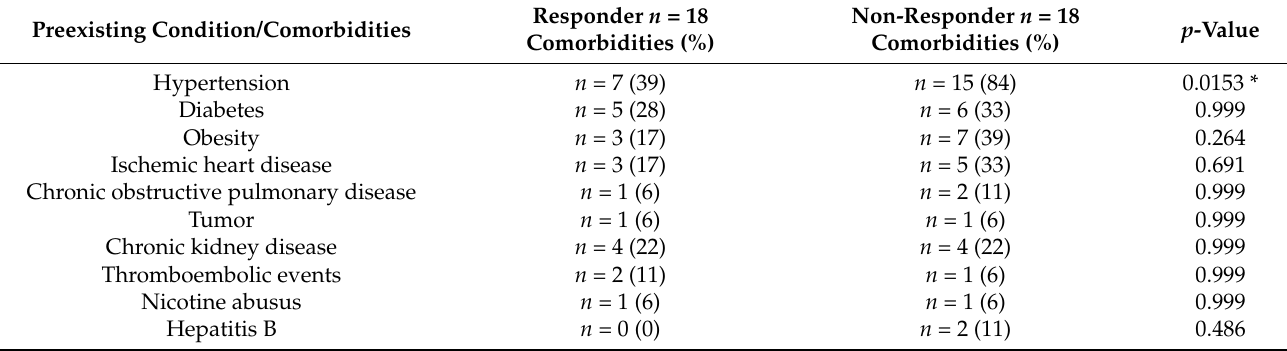
Table 1. Significantly more coronavirus disease 2019 (COVID-19) patients in the Non-Responder group suffered from hypertension by the time of ICU enrollment (* p = 0.0153). The remaining preexisting conditions are equally distributed between the